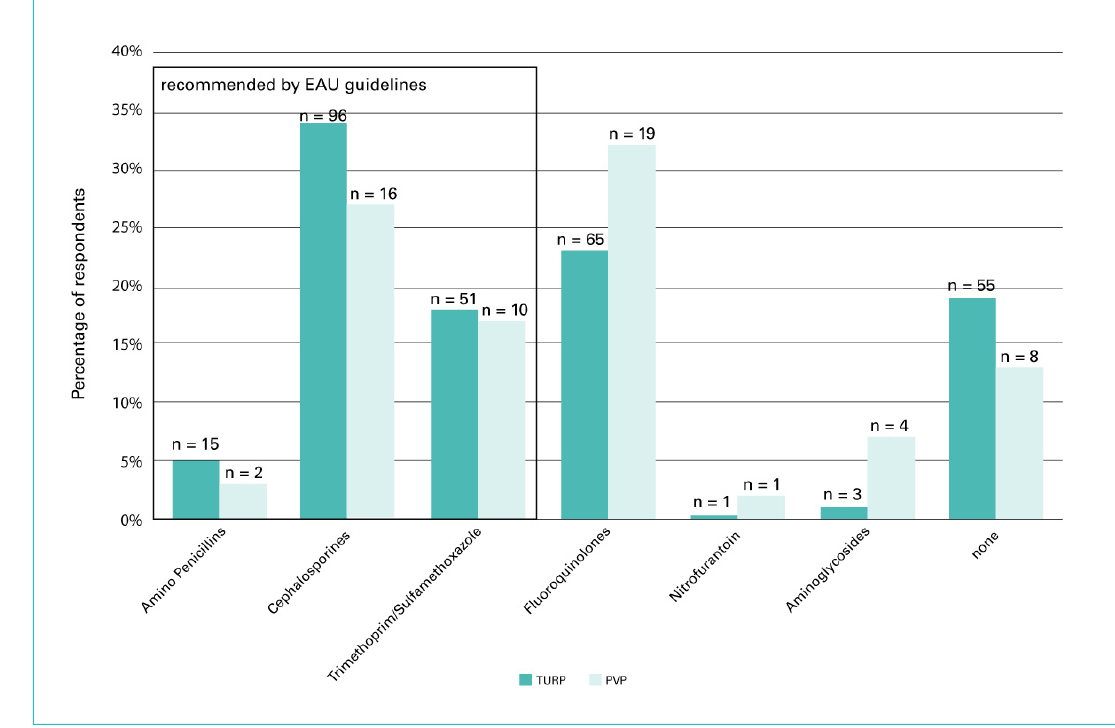
Figure 2: Perioperative antimicrobial prophylactic regimens. Despite the guidelines of the European Association of Urology (EAU), fluoro- quinolones (23%, 65/286) were second choice in transurethral resection of the prostate (TURP; 23%, 65/286) and first choice in photoselec- tive vaporisation of the prostate (PVP; 32%,